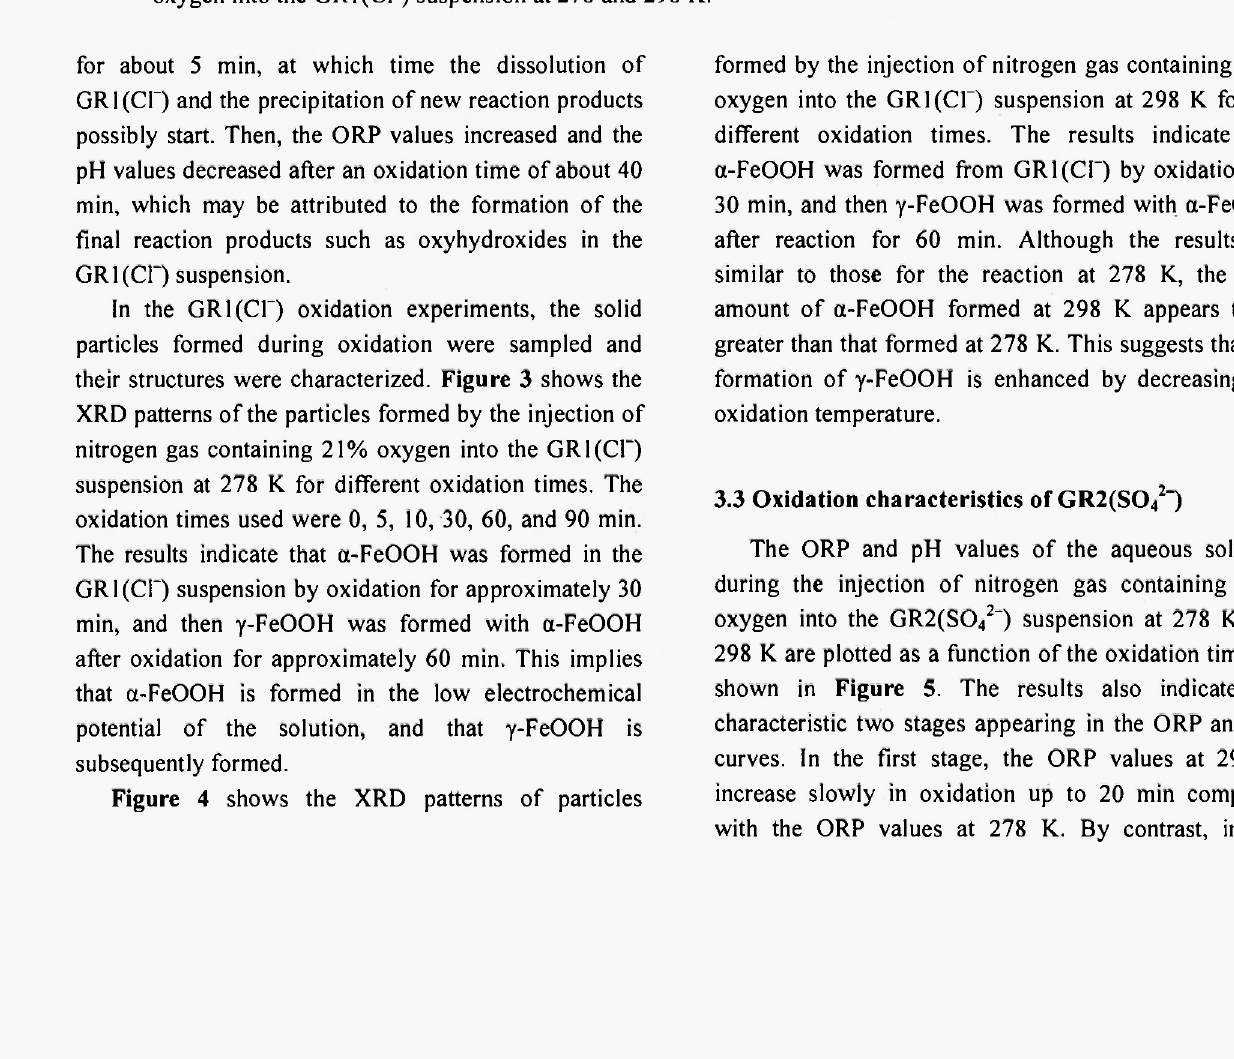
Fig. 2: Plot of ORP and pH of the aqueous solution vs. oxidation time during injection of nitrogen gas containing 21% oxygen into the GRl(CF) suspension at 278 and 298